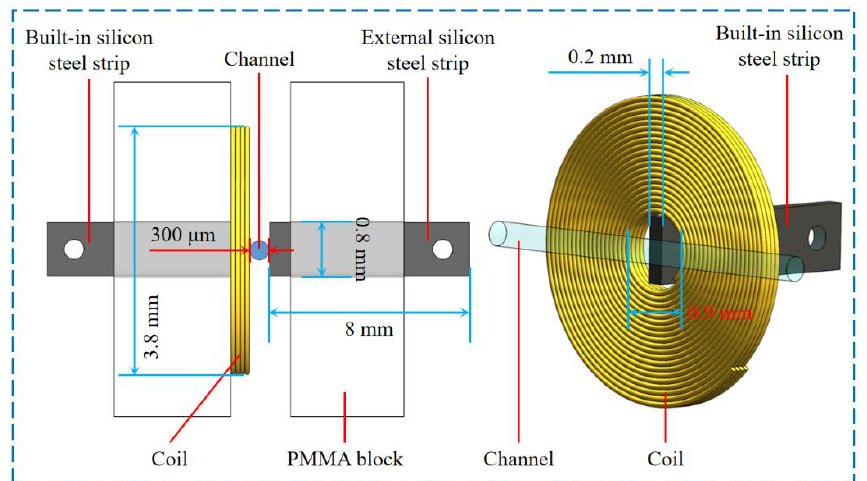
Figure 1. Overall structure diagram of impedance sensor.